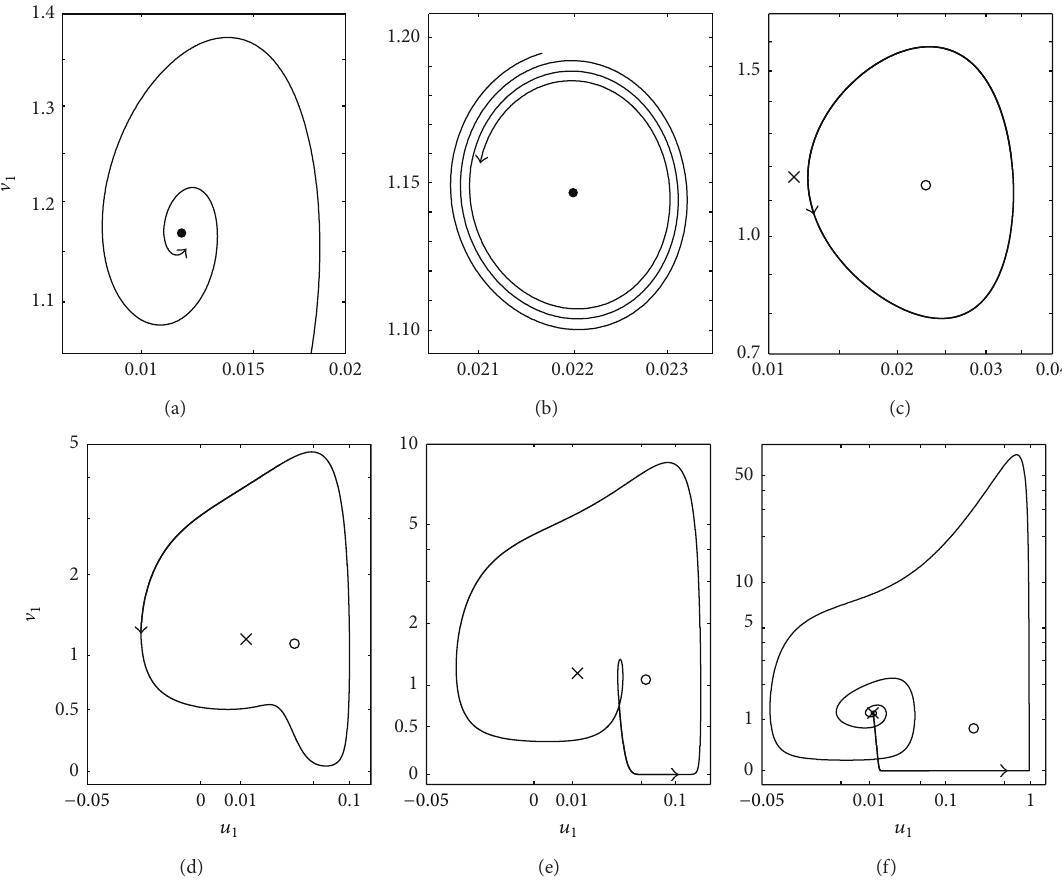
Figure 4: The development of a limit cycle in model (1a)–(1d) in relation to the coupling strength. The projections of phase trajectories and fixed points on (𝑢 1 , V 1 ) plane are presented. “ ∙ ” and “ ∘ ” mark the respective stable and unstable internal steady state 𝐹 12 ; “ × ” stands for the boundary steady state 𝐹 1 . (a) 𝜘 1,2 = 0 : CR pairs are decoupled; each has unique stable steady state. (b) 𝜘 1,2 = 0.011 : very weak coupling; the spiral winds only algebraically fast. The system is on the verge of the Hopf bifurcation. (c) 𝜘 1,2 = 0.012 : very weak coupling; the stable limit cycle is just born. (d) 𝜘 1,2 = 0.025 : weak coupling; nonlinear oscillations. (e) 𝜘 1,2 = 0.05 : moderate coupling; the limit cycle passes near the basin of the saddle point. (f) 𝜘 1,2 = 0.6 : moderate coupling; the limit cycle is about to merge with a heteroclinic